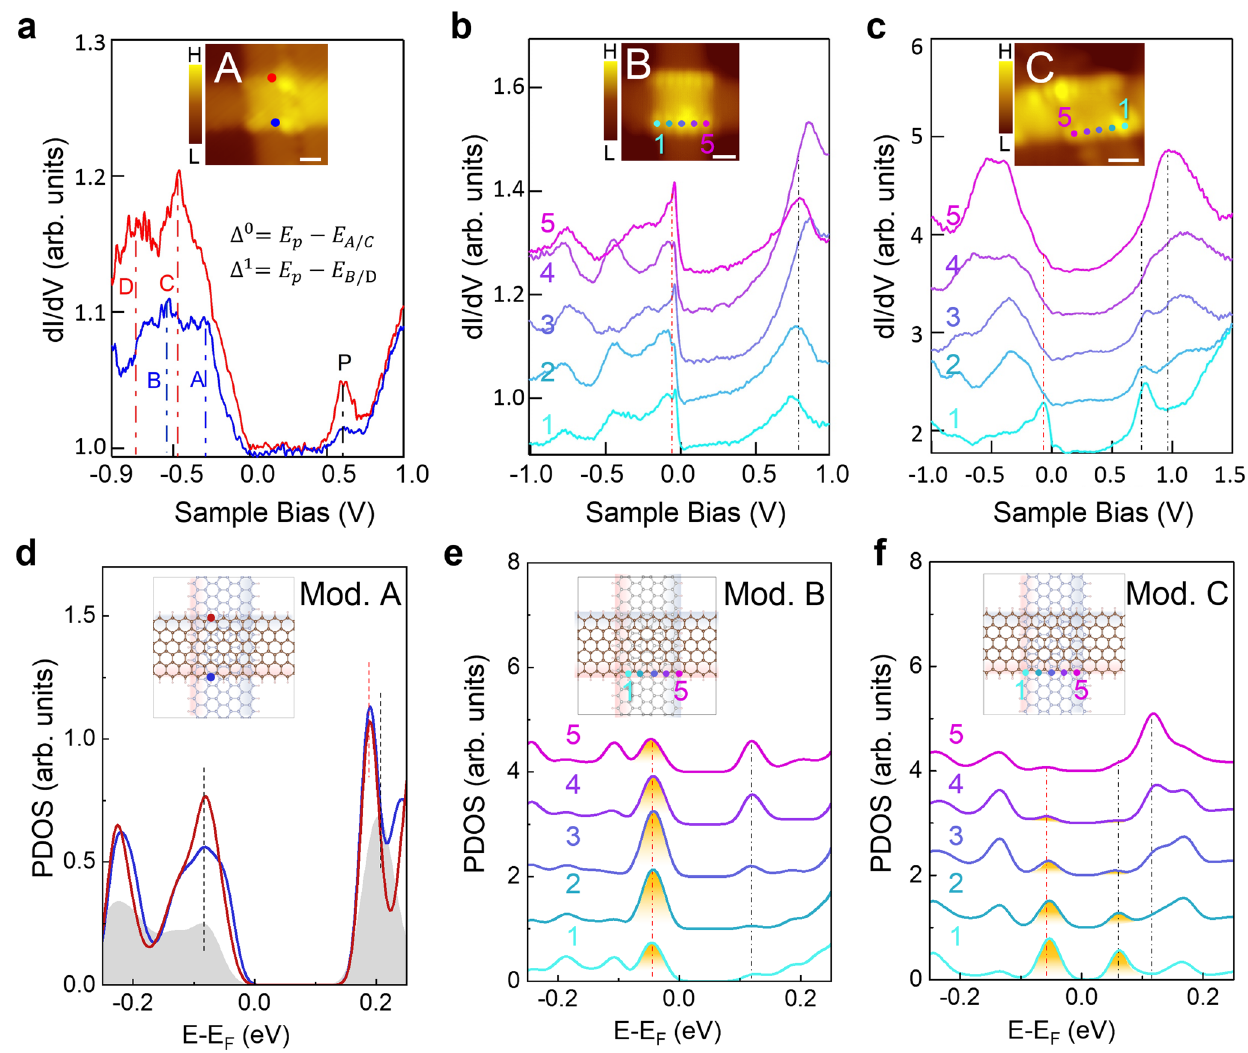
Fig.3|ExperimentalandDFTcalculatedresultsoftheedgestatesof3TBZGNR junctions with θ ≈ 90°. a – c STS taken at the zigzag edges of three TBZGNR junc- tions. Insets in a – c are the STM images of the three junctions indicating where the STSweretaken.Scalebarininsets: a 0.7nm, b 0.76nm, c 0.74nm.Thed I /d V signals only show a gap-like feature at the edge of junction A, while a pronounced peak near zero energy wasshown in TBZGNR junctions B and C (as indicated by the red verticaldashedlines).Thepronouncedpeaknearzeroenergydistributedalongthe wholebottomedgeoftheTBZGNRjunctionB,asshownin b whiledistributedonly inthevicinityofthecornerofjunctionC,asshownin( c ).Theblackverticaldashed lineshighlighttheSTSpeakpositionsabovezeroenergy. d – f DFT-calculatedPDOS fortheedgeatomsofthethreeTBZGNRModelsA,BandC.Theredandbluecurves